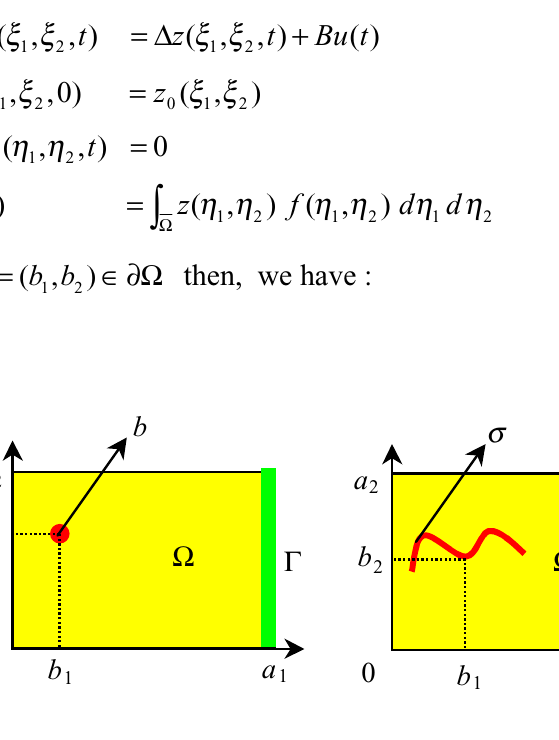
Figure 6. Rectangular domain, region Γ and locations σ , b of pointwise